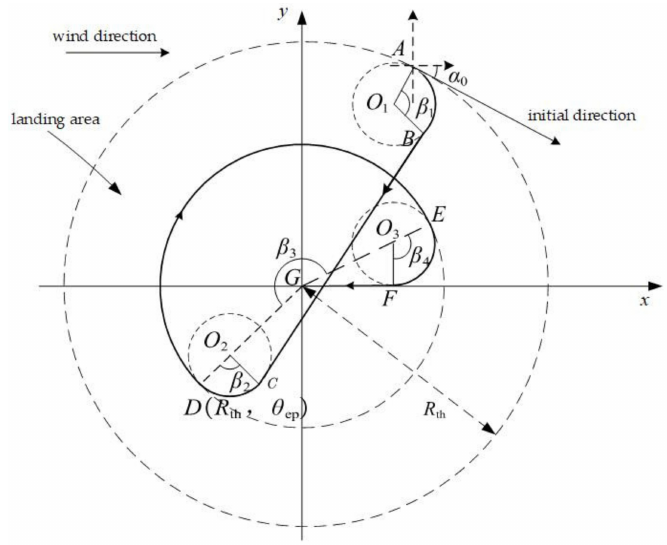
Figure 2. Schematic diagram of trajectory planning in landing